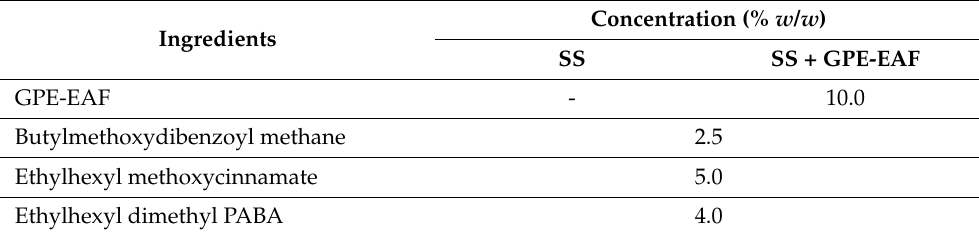
Table 1. Qualitative and quantitative of the sunscreen-system active composition.